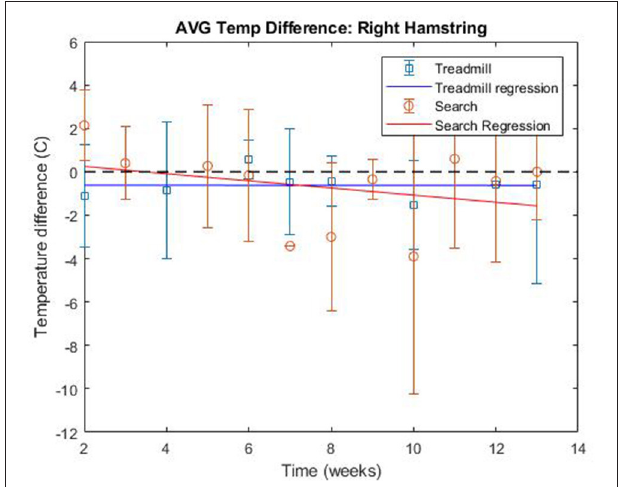
FIGURE 13 | Average thermographic intensity difference over study for right hamstring region.